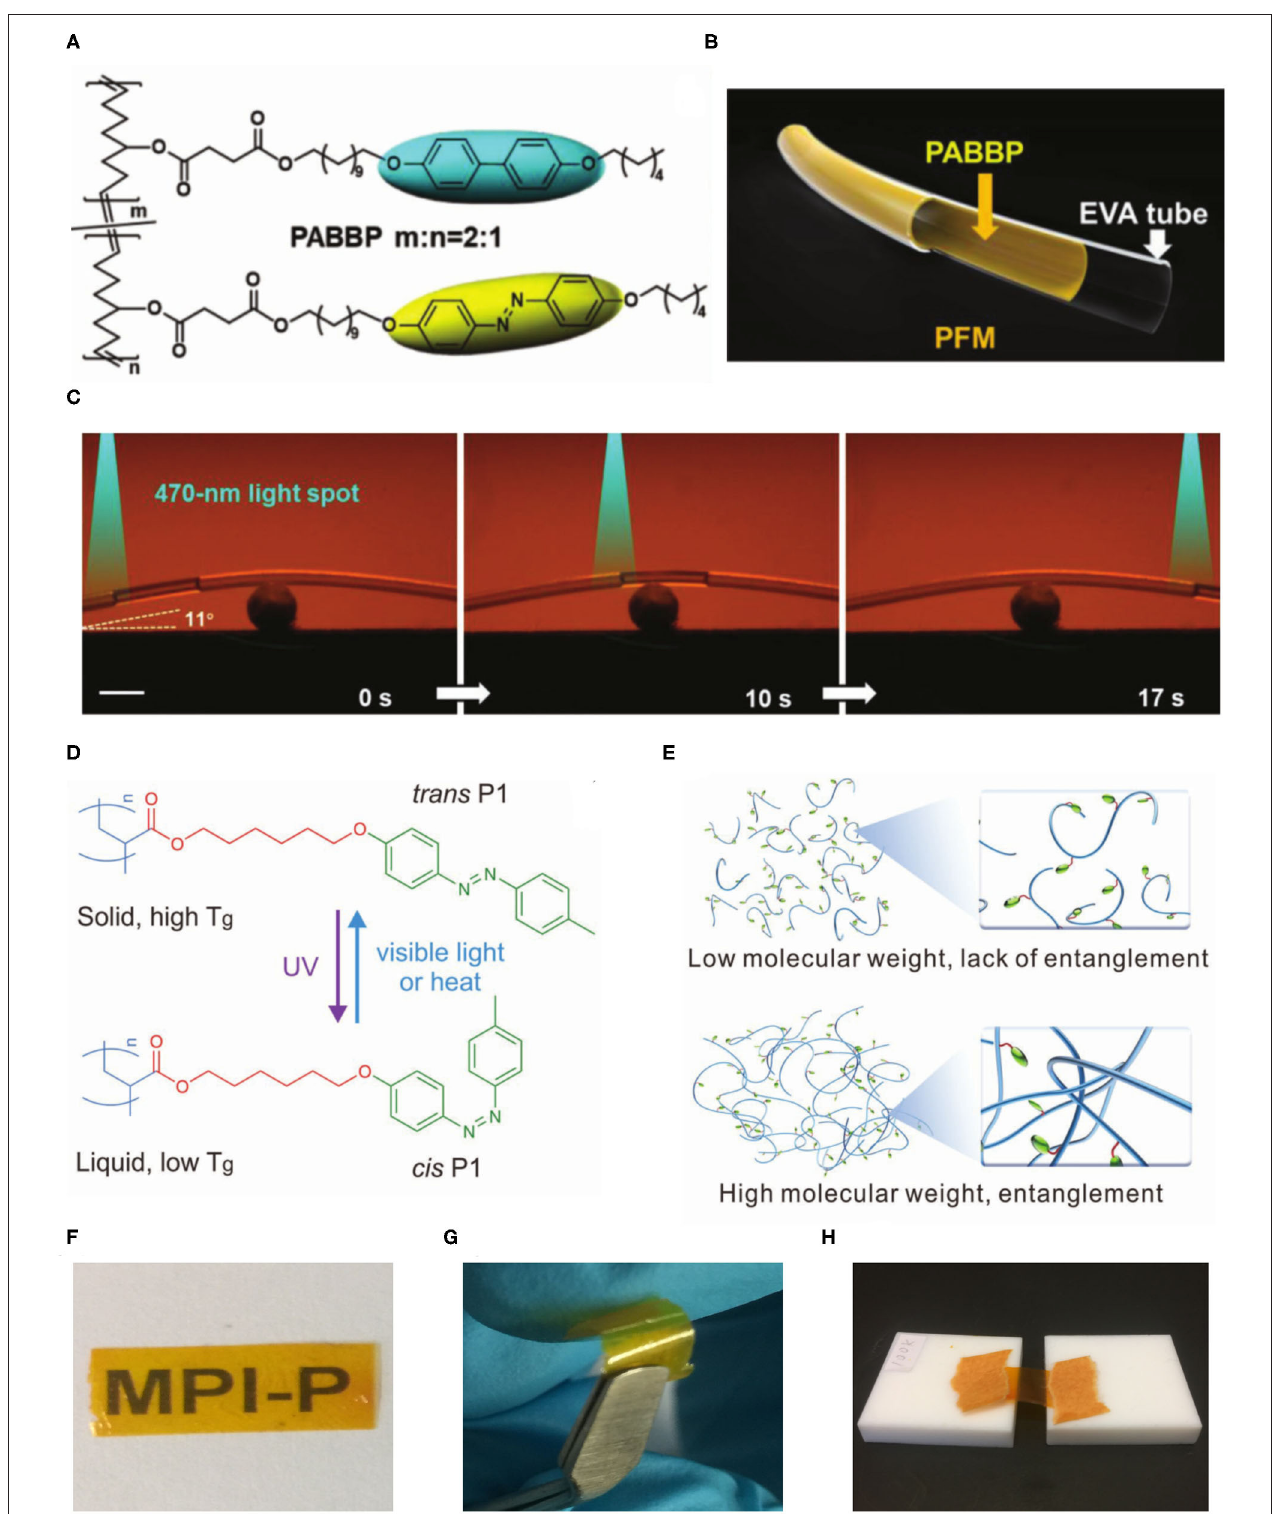
FIGURE 2 | (A) Chemical structure of the PABBP copolymer. (B) Schematic representation of the bilayer structure of the PFM. (C) Photographs of the light-controlled motion of an isopropanol slug climbing over a slope of 11 ◦ incline in a curved PFM. The intensity of the 470nm point light was 120 mW cm − 2 . The scale bar is 2mm. (A–C) Reprinted with permission from Xu et al. (2019) Copyright Wiley-VCH. (D) The chemical structure and photoisomerization of P1. (E) Schematic representation of